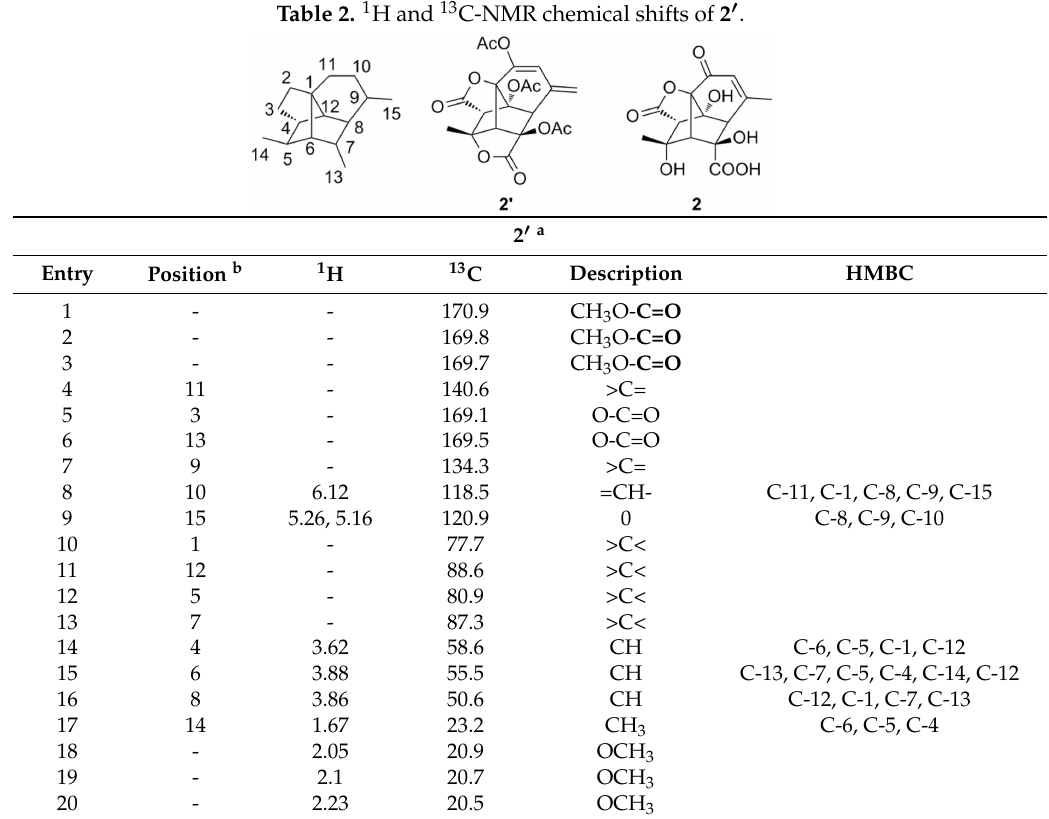
Table 2. 1 H and 13 C-NMR chemical shifts of 2 (cid:48) .